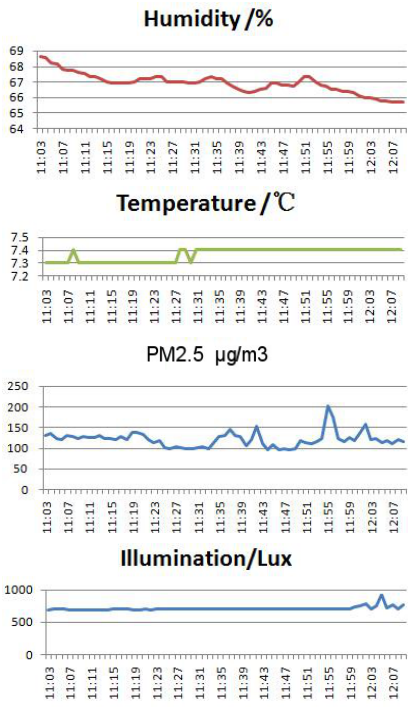
Figure 7. Some data of air quality from